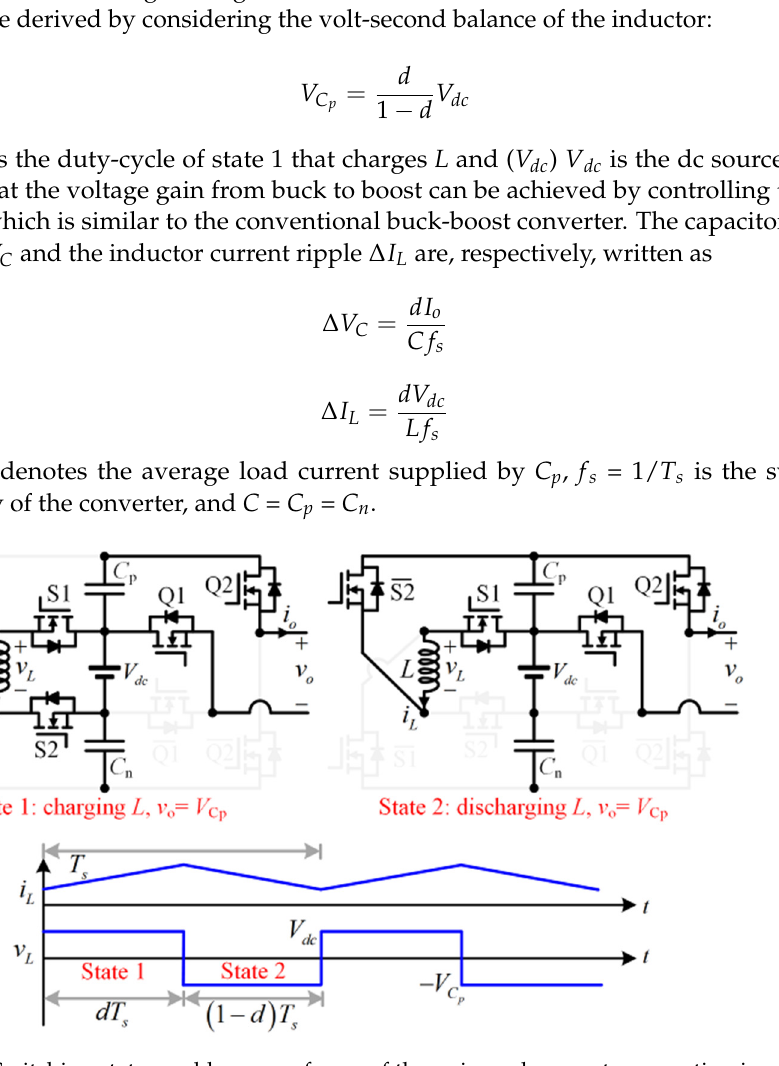
Figure 1. Proposed dual-buck-boost dc–dc/ac universal converter.